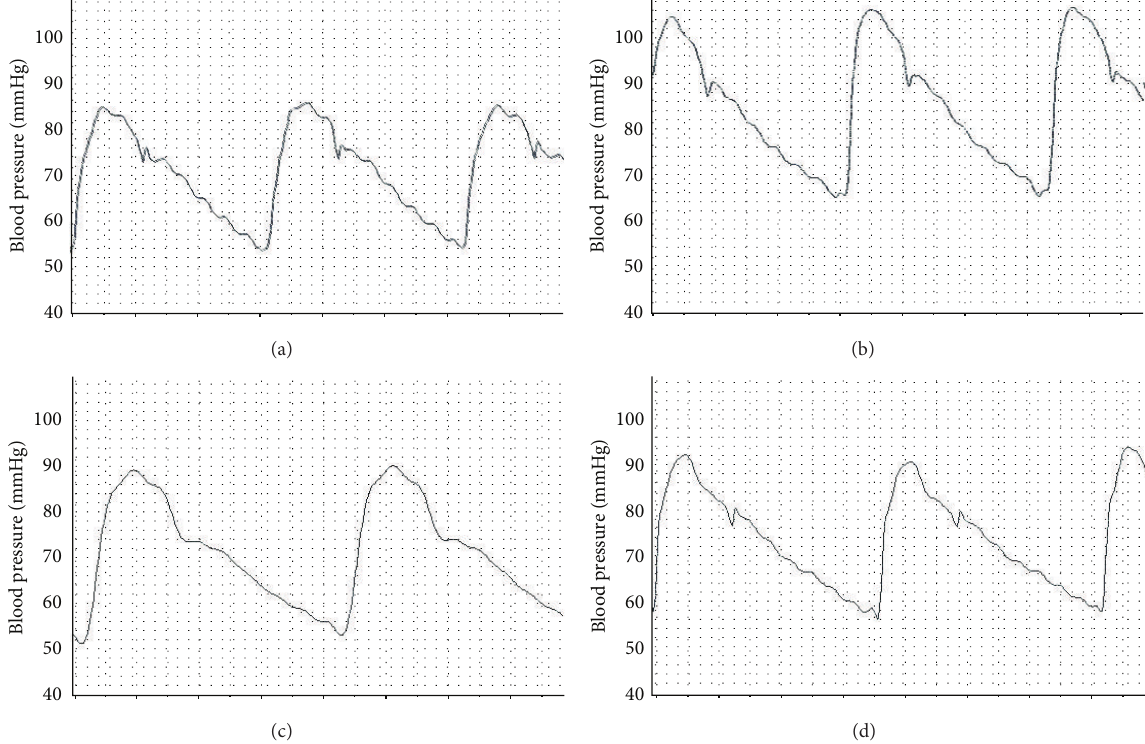
Figure 2: The effect of allopurinol on insulin resistance induced blood pressure changes in BP tracing. Normal control BP (a) shows control systolic and diastolic pressure. IR BP tracing (b) shows increase of both systolic and diastolic BP. IR + allopurinol (c) shows nearly normalized diastolic BP with significant decrease of the elevated systolic BP and increase in the diastolic time. Control + allopurinol (d) shows nearly normal systolic and diastolic BP with minimal increased diastolic